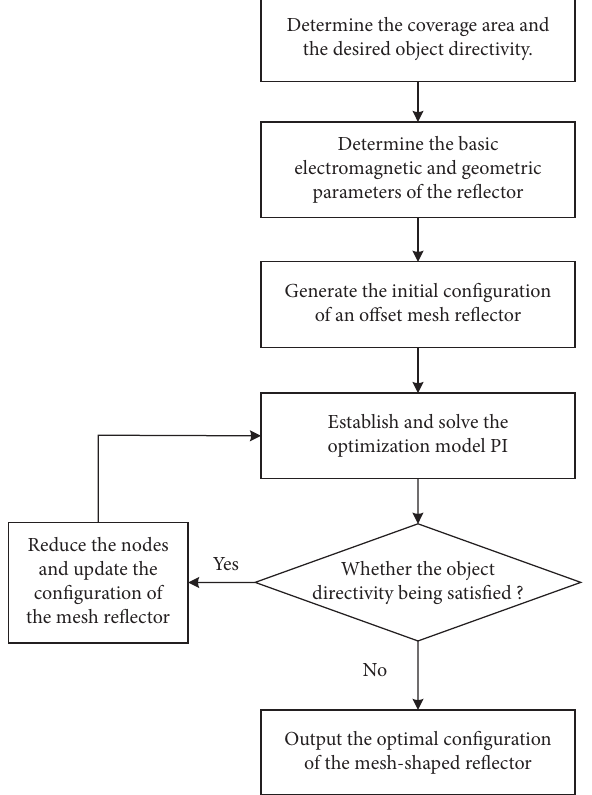
Figure 3: Iteration design flow